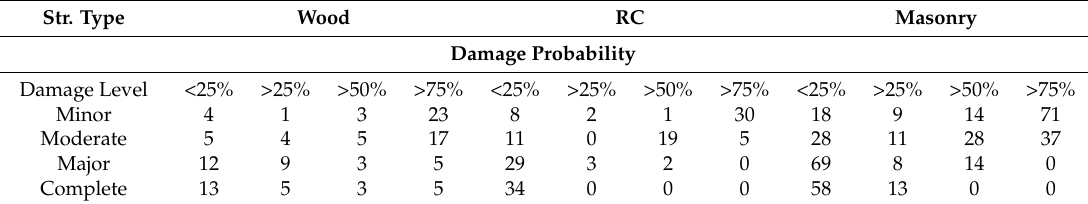
Figure 11. Percentage probability for structures undergoing major damage due to tsunami. Table 5. Number of buildings at each damage level according to the structure material type. Str. Type